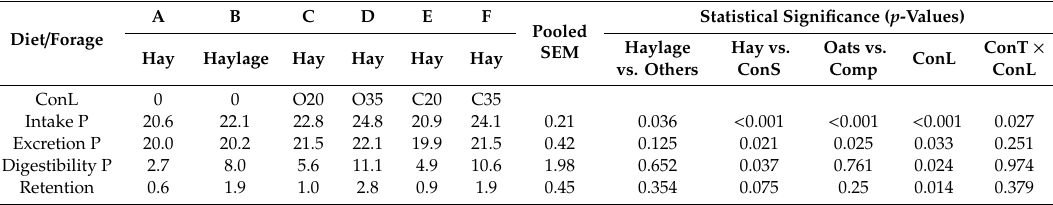
Table 3. Daily intake (g), fecal excretion (g), digestibility (%) and retention (g) of phosphorus (P). Diet / Forage